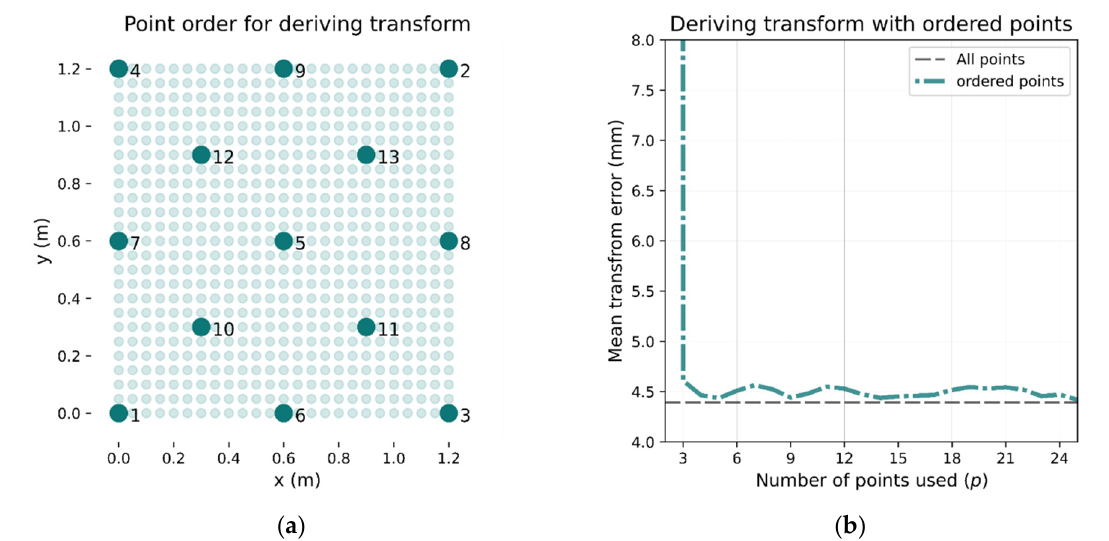
Figure 8. Selecting calibration points to maximize area covered. If points are chosen by following the pattern in ( a ), then the transform accuracy converges much faster, as can be seen in ( b ). With only 3 calibration points, the mean error is below 5 mm (shown in ( b )).